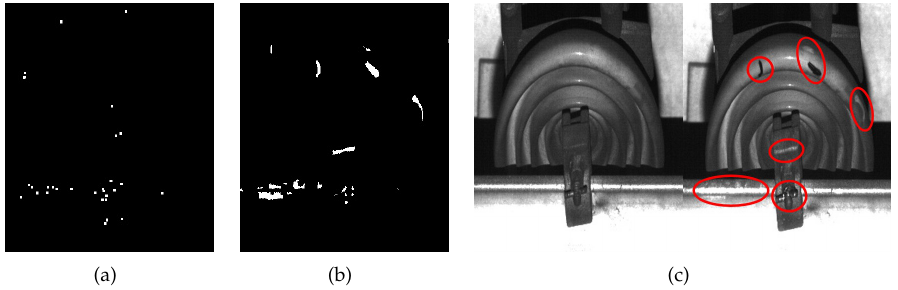
Figure 11. Defect detection result: ( a ) noisy image; ( b ) detected defect regions using the proposed system; and ( c ) a pair of image with the deformed